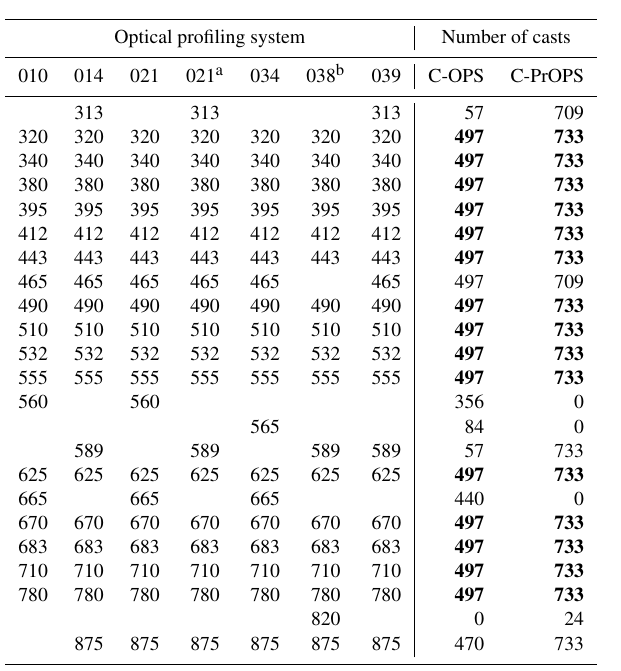
Table 1. The nominal fixed wavelengths in nanometers, all with 10nm bandwidths, for each optical profiling system as distin- guished by serial number. The number of casts obtained is differ- entiated between backplanes without (C-OPS) and with (C-PrOPS) digital thrusters (note system 021 had both), wherein boldface num- bers indicate the 15 wavelengths common to all profiling systems, e.g., 320 and 780nm.